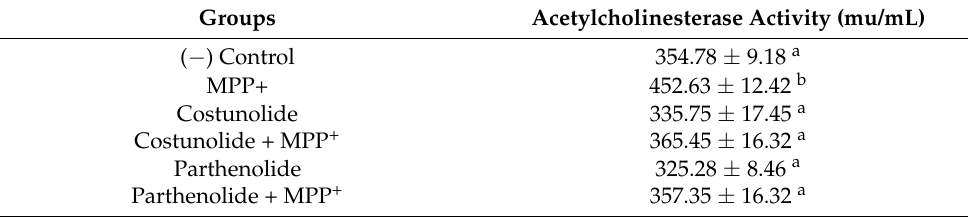
Table 1. Acetylcholinesterase activity (mu/mL) of in vitro Parkinson’s Disease model with/without treatment of costunolide and parthenolide terpenoids after 24 h. One-way ANOVA, Dunnett tests were used for multiple comparison. Different letters in the same column present statistical significance from each value, p < 0.05.